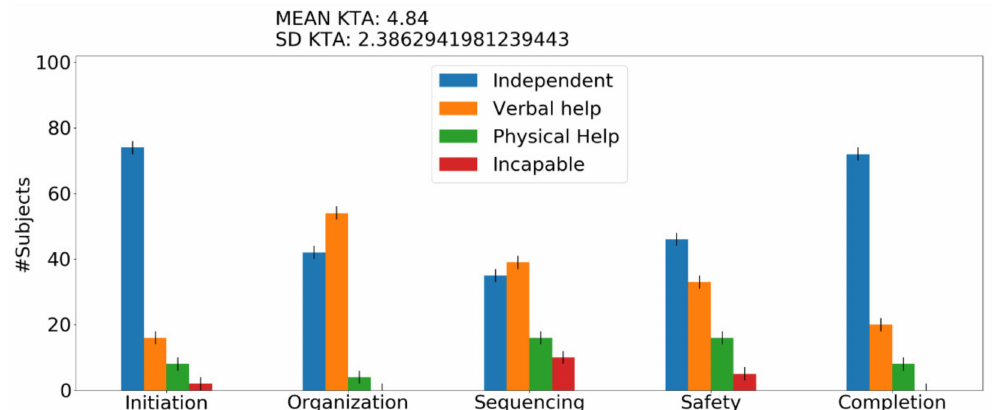
Figure 4. Main graphical output of the conceptual framework. The blue bars represent the number of subjects who completed a category of steps independently. The orange and green bars represent the number of subjects who requested help (verbal or physical) in a category of steps. The red bars indicate the number of subjects who are incapable of performing theses steps under a specific category. This activity corresponds to the tea preparation activity with mild